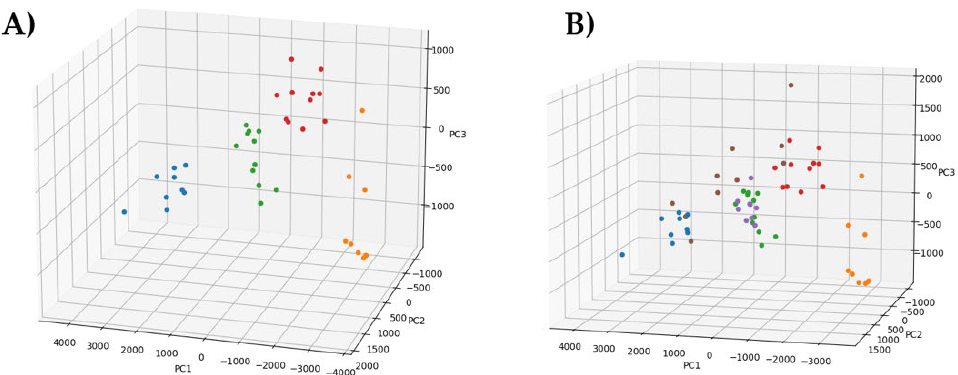
Figure 5. The three principal components explain ~60% of the variance for 24 h samples in ( A ) monocultures and ( B ) monocultures + cocultures. Code: E. coli (blue), L. monocytogenes (orange), S. aureus (green), S. enterica (red), L. monocytogenes + S. aureus (purple), L. monocytogenes + S. enterica (brown).